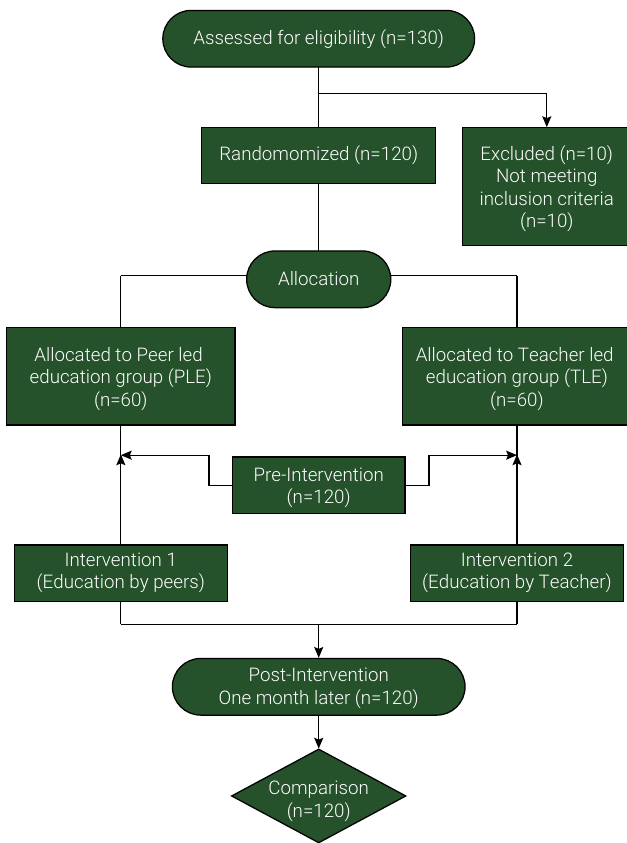
Figure 1. Flow diagram of methodology